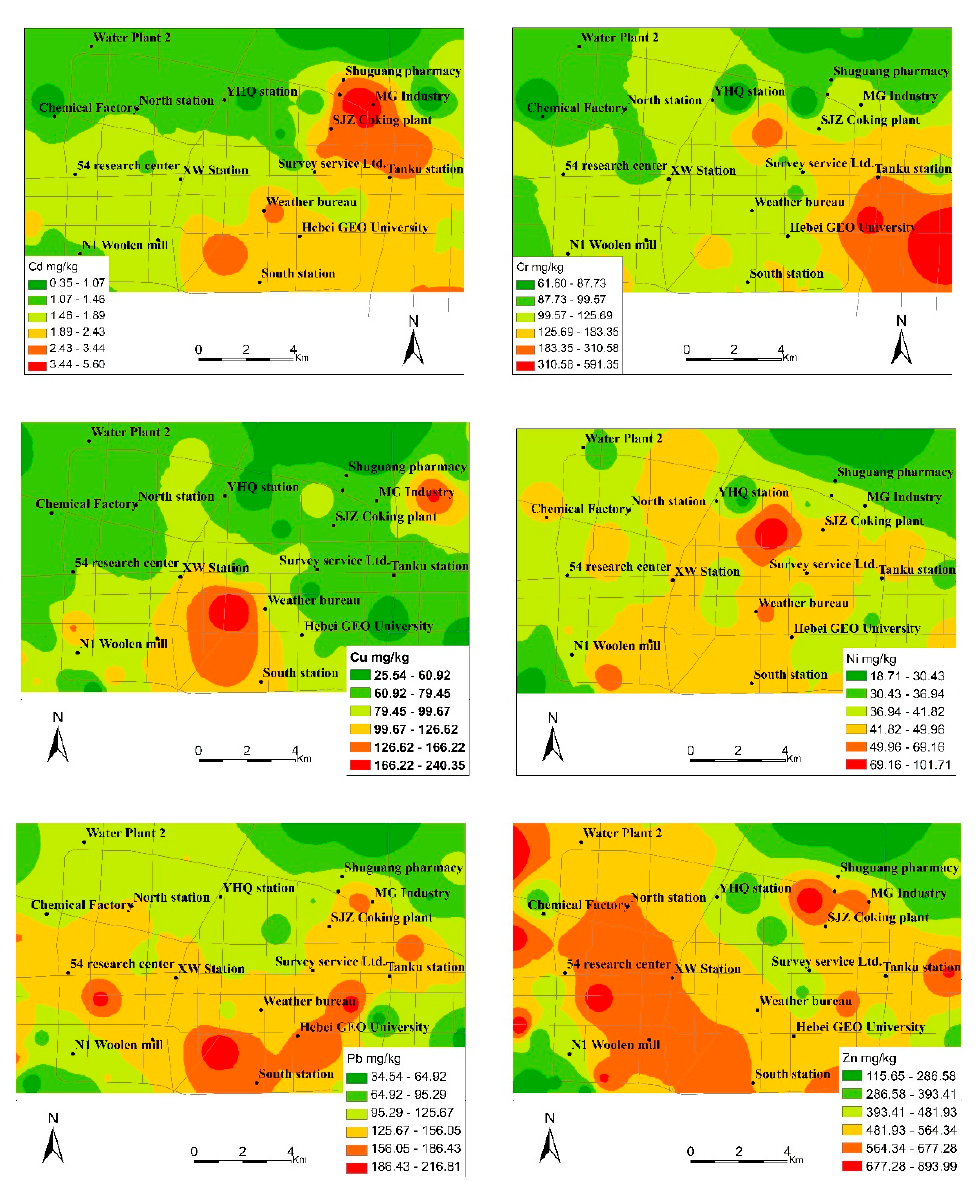
Figure 3. Spatial distribution of heavy metals (Cd, Cr, Cu, Ni, Pb, and Zn).